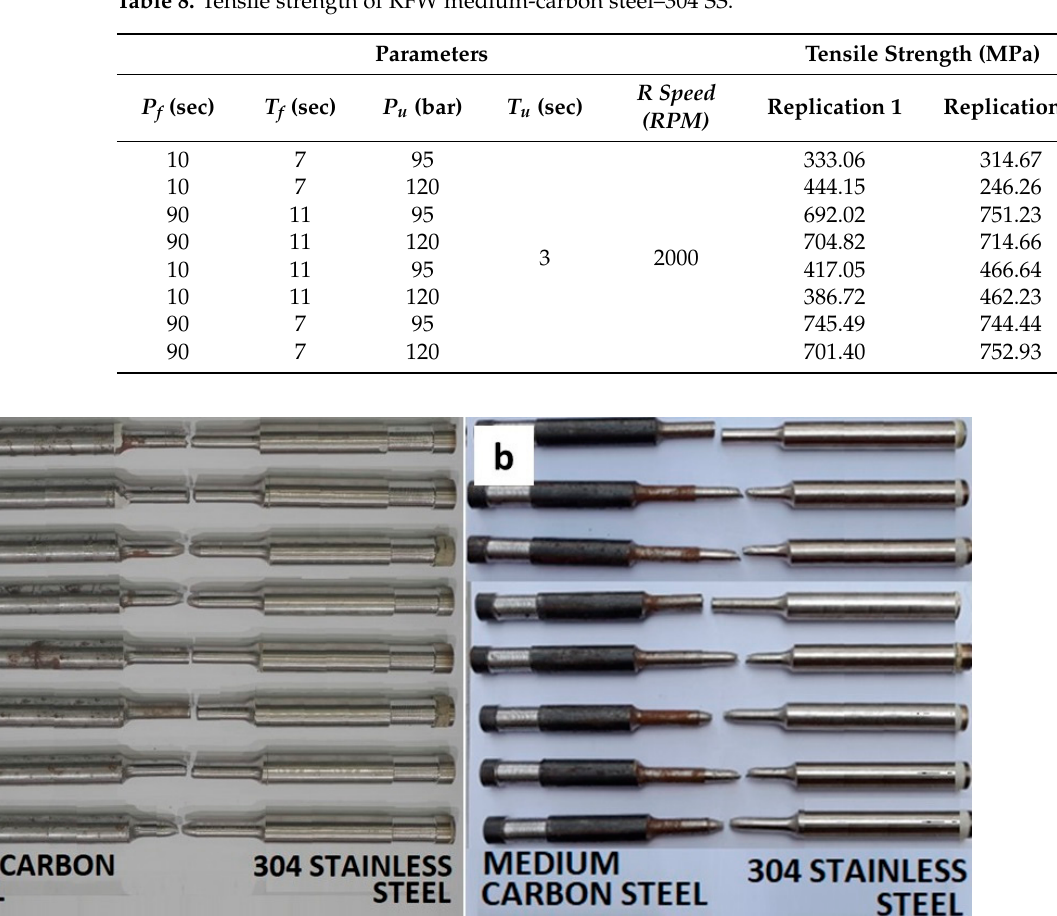
Table 8. Tensile strength of RFW medium-carbon steel–304 SS.